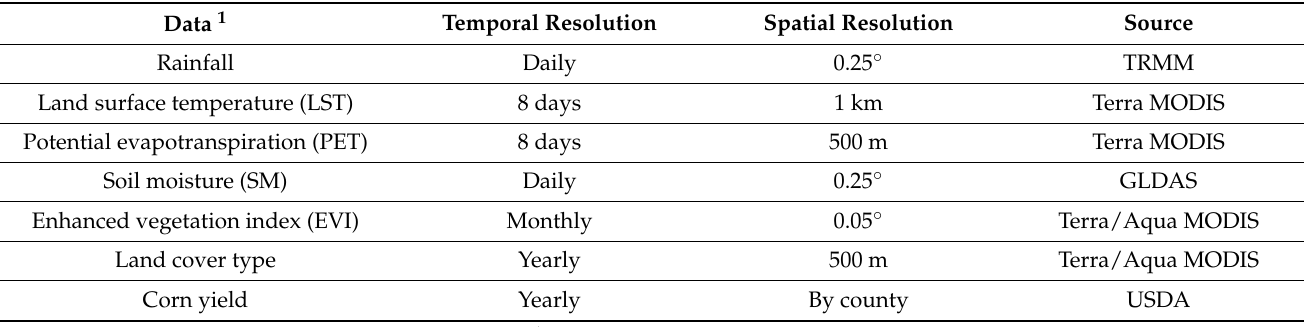
Table 2. Data used to develop the integrated crop drought index (ICDI).